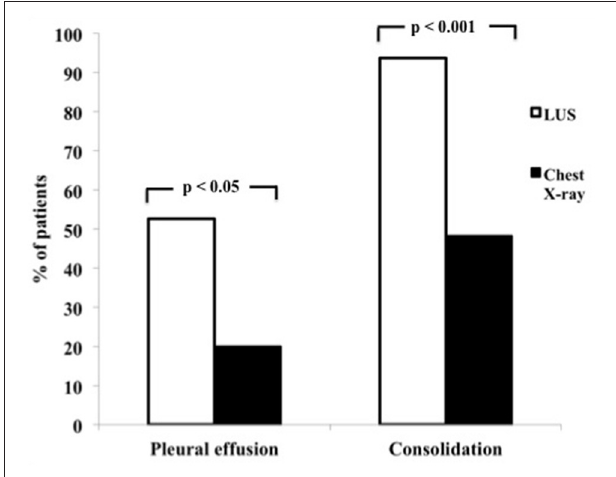
FIGURE 1 | Percentage of pleural effusion and lung consolidation assessed by LUS and chest X-ray.